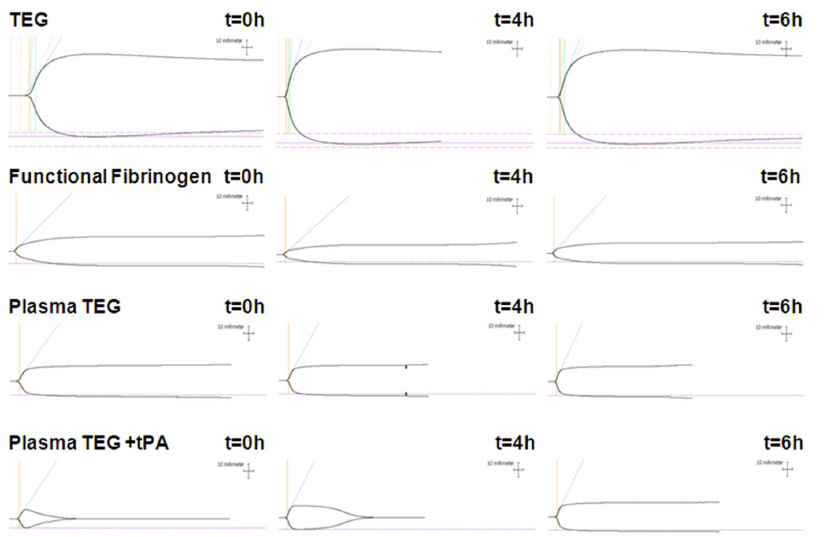
Figure 1. Representative profiles of TEG and modified TEG analyses in healthy volunteers before (t=0), during (t=4 h) and after (t=6 h) experimental endotoxemia induced by a 4-hour continuous intravenous infusion of purified Escherichiacoli LPS (infusion rate 0.5 ng/kg/hour). TEG and Functional Fibrinogen were analyzed in whole blood whereas plasma TEG was analyzed in plasma with or without addition of 1.8 nM tPA to induce lysis of the clot i.e., allowing extended evaluation of clot resistance to fibrinolysis.